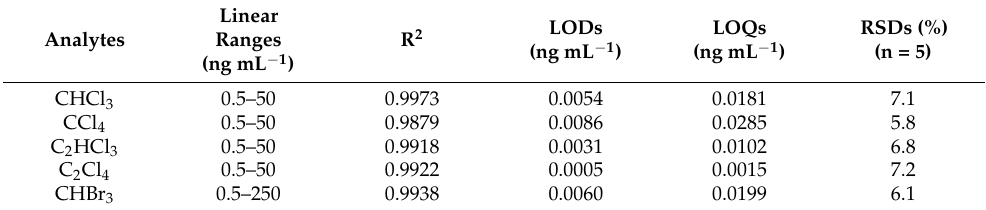
Table 1. Analytical performance of PAA/N-SPCs SPME coating for VHCs. Analytes